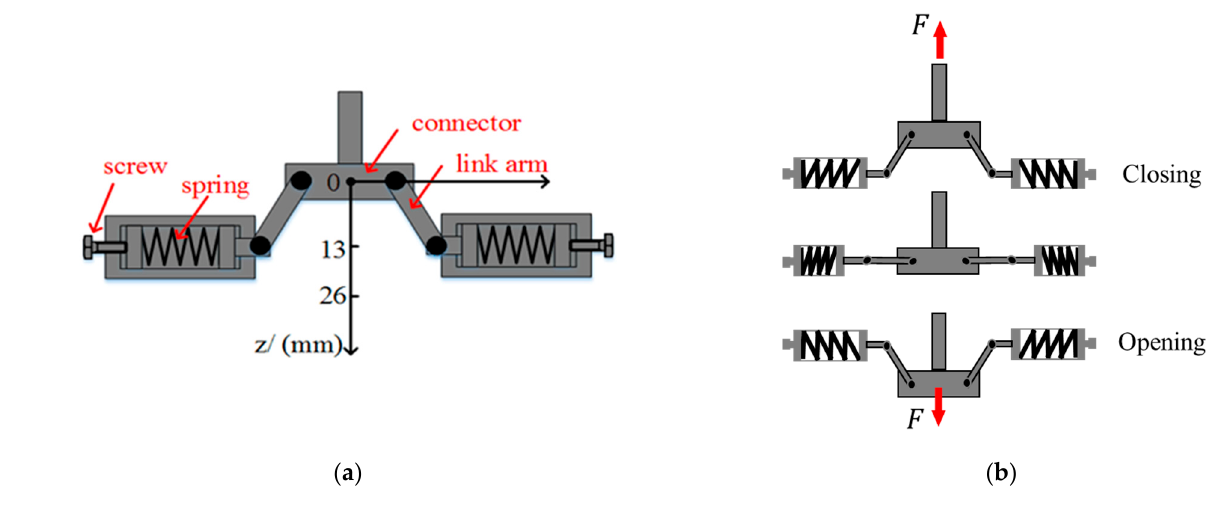
( b ) Figure 8. Disc spring mechanism: ( a ) disc spring, redrawn as depicted in [66]; ( b ) buckling spring ribbons, redrawn as depicted in [85]. 3.2.4. Magnet Holding Mechanism The typical permanent magnet (PM) holding mechanism is composed of a permanent magnet, a moving iron core, a static iron core, and a magnetic conducting ring, as shown in Figure 9. Different from the permanent magnet operating mechanism used for driving, the permanent magnet holding mechanism does not include an opening and closing coil for driving. The permanent magnet holding mechanism utilizes the magnetic force of the permanent magnet and the iron core to provide the holding force and is generally de- signed as a two-way holding mechanism to provide the holding of opening and closing. The permanent magnet holding mechanism was used in [50,51,60,61] due to its simple structure, its maximum holding force at the opening and closing positions, its small out- put force in the middle position, and its output characteristics, which meet the require- ments of the rapidity of the TCA repulsion mechanism. However, the permanent magnet holding mechanism has problems such as a large moving mass and demagnetization of